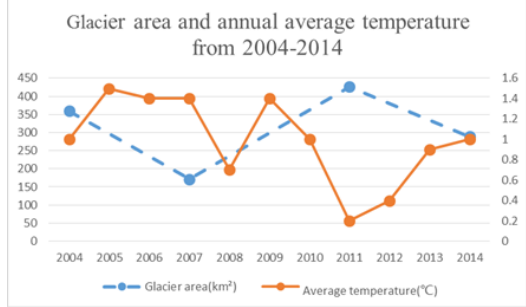
Figure 7. Glacier area and annual average temperature from 2004-2014